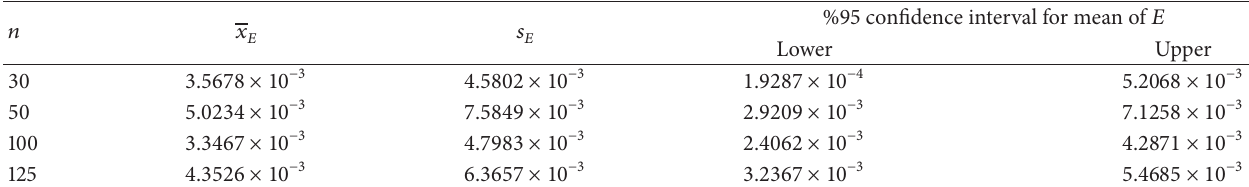
Table 1: Mean, standard deviation, and confidence interval for error mean in Example 1 with 𝑚 = 4 , 𝑘 = 4 .